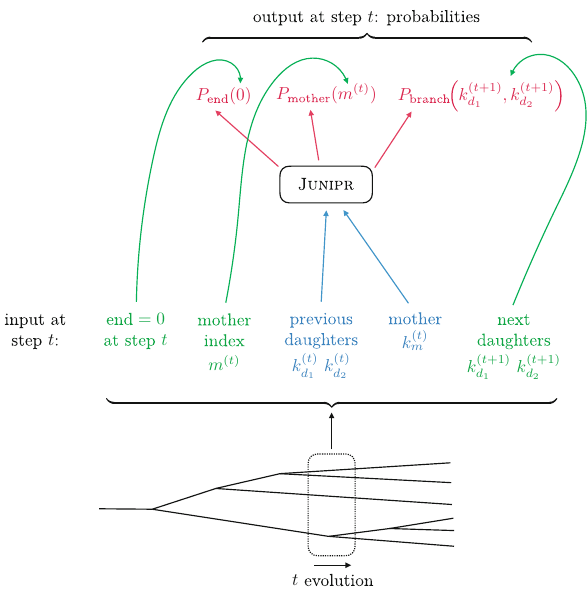
Fig. 5 Using Junipr to evaluate the probability density over final-state momenta in a jet. For a given jet and its particular clustering tree, the values associated with the tree ending, which momenta branch, and the emerging daughters are all known and plugged into the probability dis- tributions directly. The probability density of the jet is then the product over the three distributions, over all splitting steps t